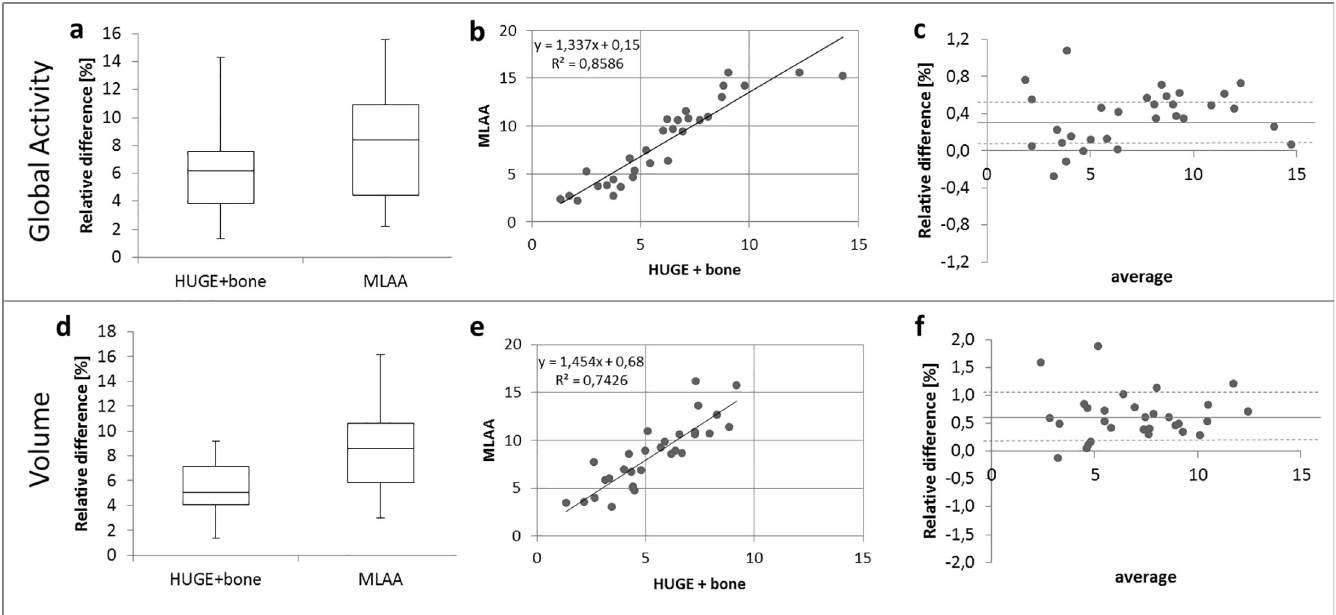
Fig 2. Statistical analysis of quantitative impact of improved AC on AC-map volume and PET signal. Statistical analysis of quantitative impact (global activity) of HUGE field-of-view extension, bone segmentation and MLAA correction on global PET signal over all segments of the left ventricle (a-c). Increase of AC-map volume (d-f) relative to AC-map volume as provided by standard Dixon-VIBE AC imaging. Boxplots (a, d) show the statistical distribution in relative gain of activity and volume from applying improved AC. Correlation graphs (b, e) and Bland-Altman plots (c, e) depict the comparison between HUGE + bone and MLAA in contrast to standard Dixon-VIBE AC serving as reference. In the correlation graphs (b, e) the linear equation with the coefficient of determination (R 2 ) is given.